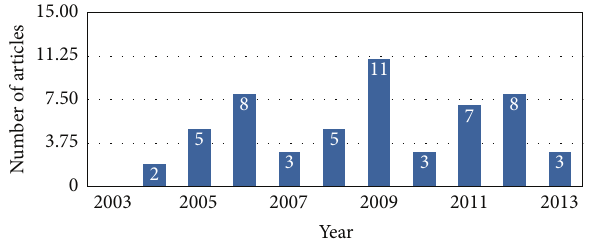
Figure 1: Published articles (𝑛 = 55) containing histological and microbiological data from January 2003 to December